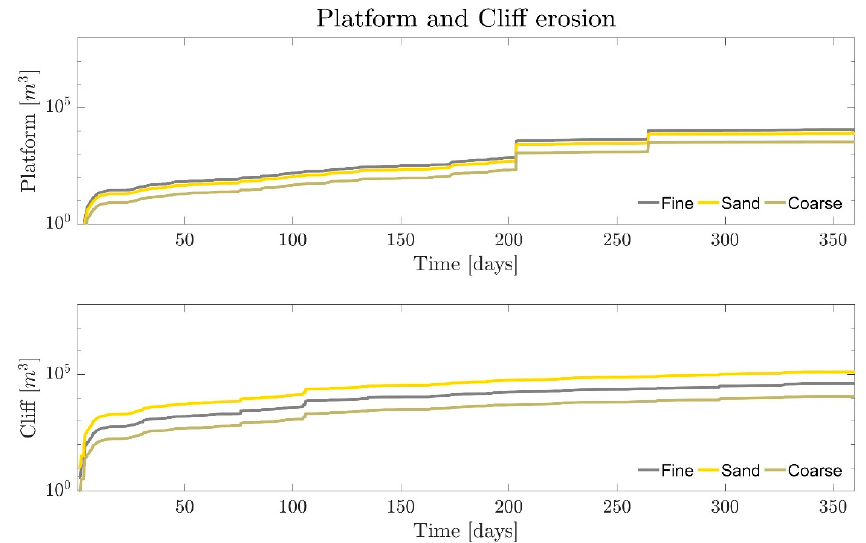
Figure 16. Daily accumulated platform and cliff erosion sediment volume. All fine material eroded from the platform, cliff and beach becomes suspended sediment.